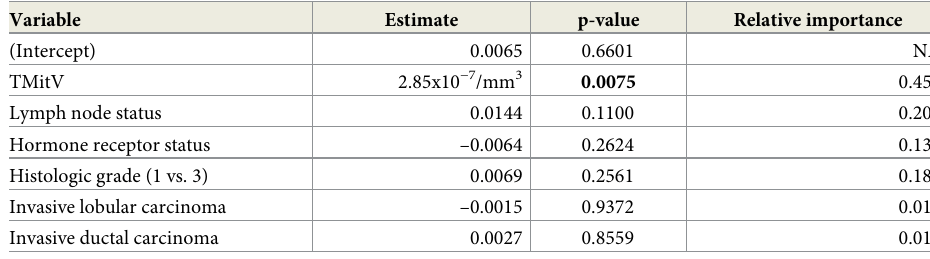
Table 1. Analytical model for breast cancer.